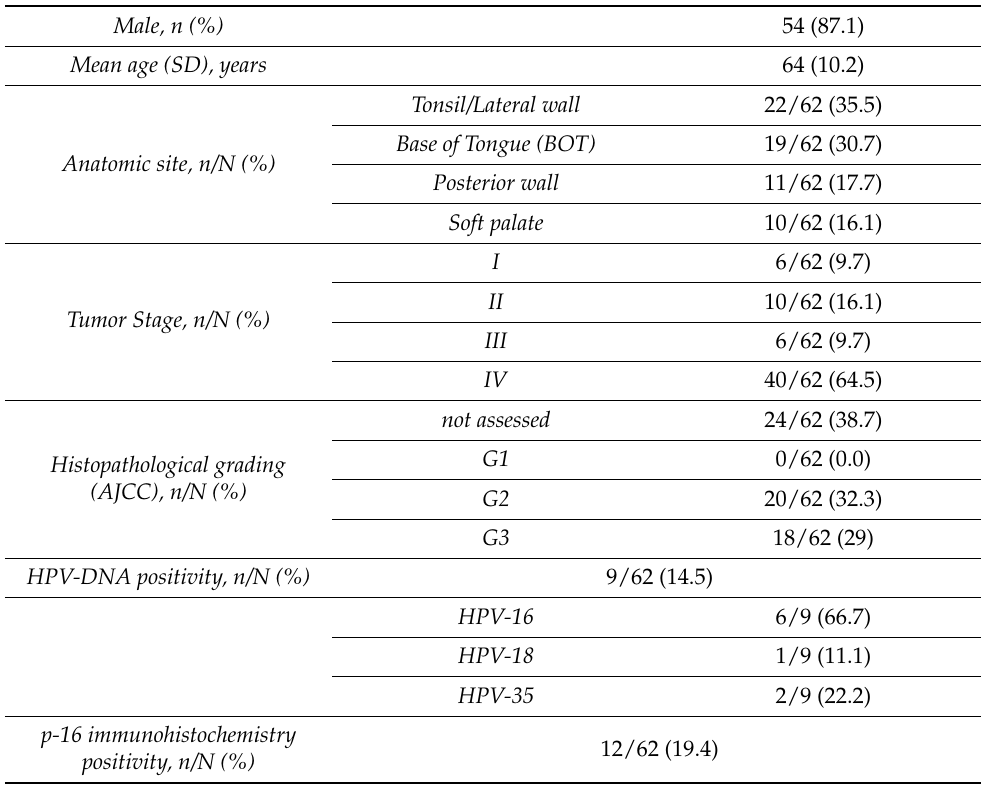
Table 1. Descriptive statistics.